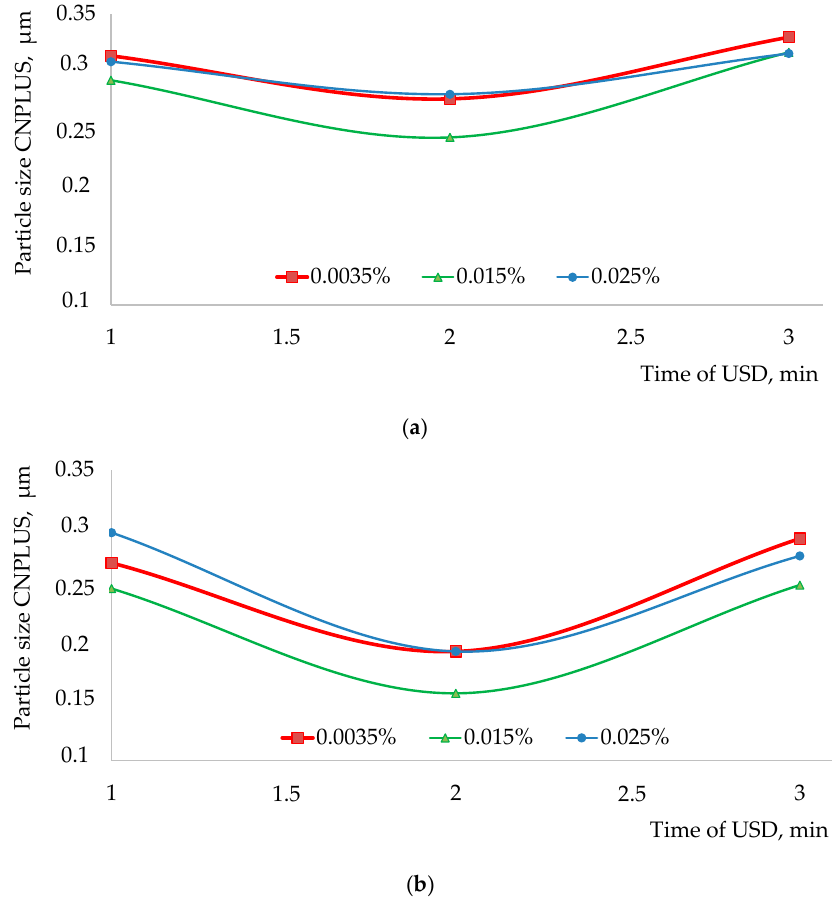
Figure 4. The dependency of the influence of the plasticizer’s content on the duration of ultrasonic dispersion of CNPLUS: ( a ) ViscoCrete 2100; ( b ) Tensafor.